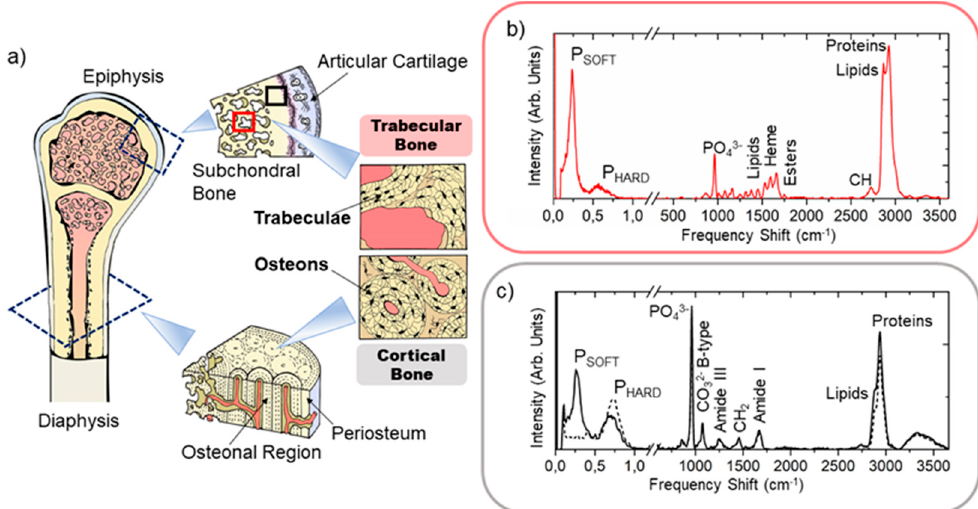
Figure 1. ( a ) Graphical sketch of the human femoral bone describing anatomical regions of interest (i.e., the epiphysis and the diaphysis, with their macroscopic organization in cortical bone and trabecular bone tissues). Black square: cortical bone; red square: trabecular bone. Typical Brillouin (before the break) and Raman (after the break) spectra were collected in ( b ) the trabecular bone (red) and in ( c ) the cortical bone (black dashed line—extracellular matrix portion; black solid line—blood vessels portion) of the frozen femoral epiphysis, reporting the signatures of characteristic peaks.